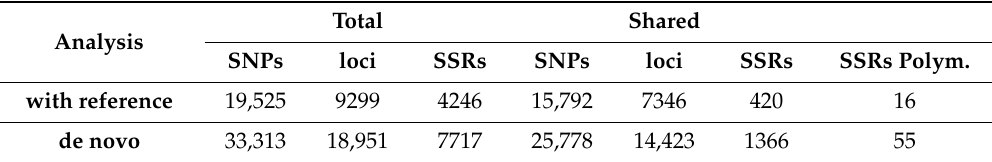
Table 2. Comparison of ddRADseq loci and polymorphic markers identified in two samples using with reference and de novo analyses. Number of SNPs and SSRs markers discovered by with reference and de novo analyses with Protocol 1. Total: total discovered markers; Shared: markers shared between both